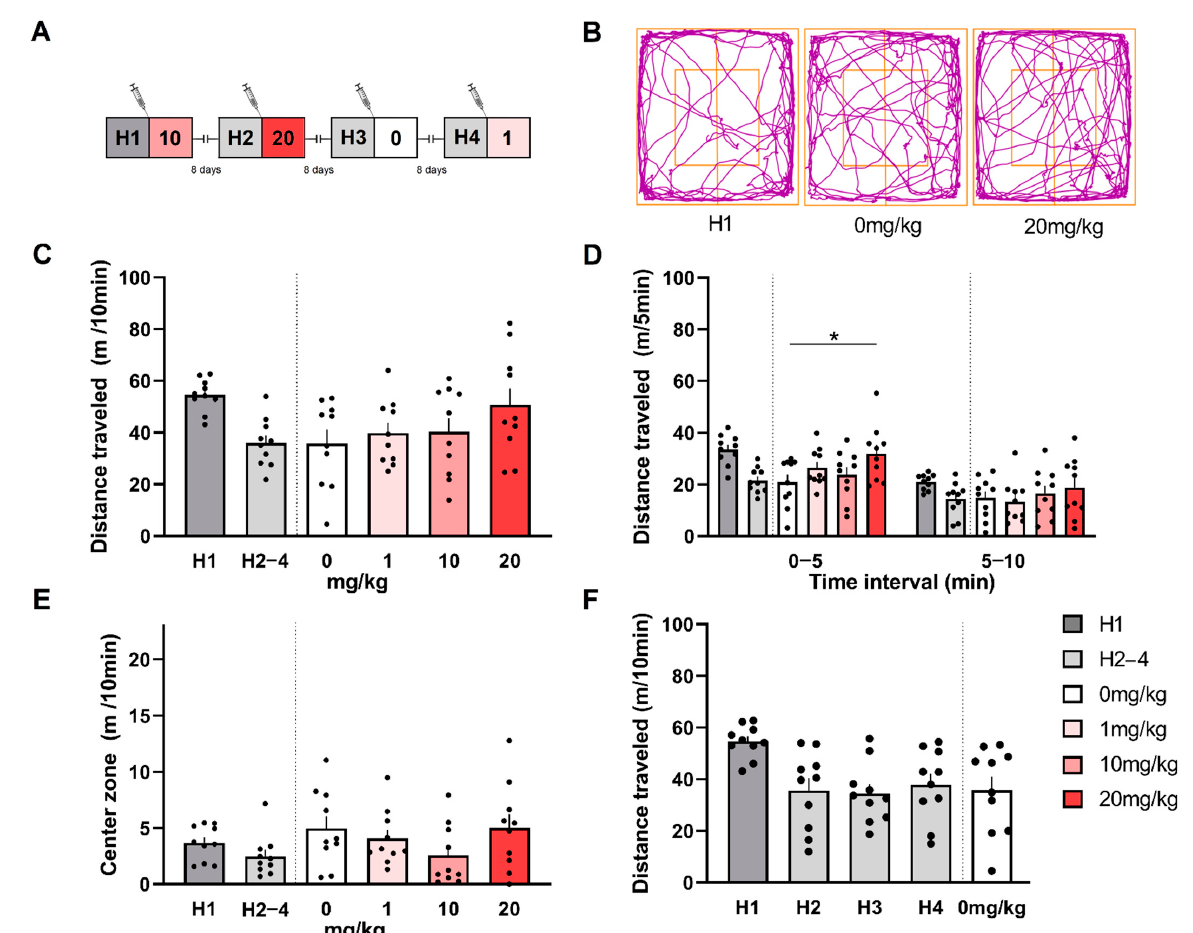
Figure 6. Effect of ( S )-MK-26 (1, 10, 20 mg/kg body weight) on locomotor activity in an open-field apparatus. ( A ) Schematic demonstration of experimental design. ( B ) Representative traces of locomotor activity recorded during H1 session and test session with vehicle and 20 mg/kg treatment with ( S )-MK-26. ( C ) Total distance travelled over the 10 min test session and ( D ) over 5 min segments. ( E ) Distance travelled in center zone. ( F ) Baseline activity measured during habituation sessions (H1—novelty OF session; H2–4—familiar OF sessions) and vehicle session (0 mg/kg). One-way RM-ANOVA followed by Dunnett post hoc test for multiple comparisons; * p < 0.05. Values